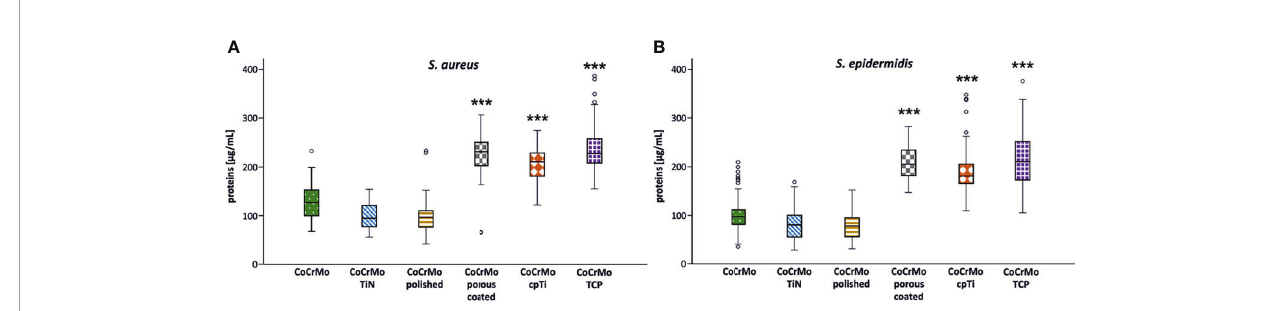
FIGURE 5 | Protein concentration of S. aureus ( A ; n = 42) and S. epidermidis ( B ; n = 44) bio fi lms. Statistically signi fi cant differences to CoCrMo are marked *** (adjusted signi fi cance < 0.001, Bonferroni correction for the Kruskal –